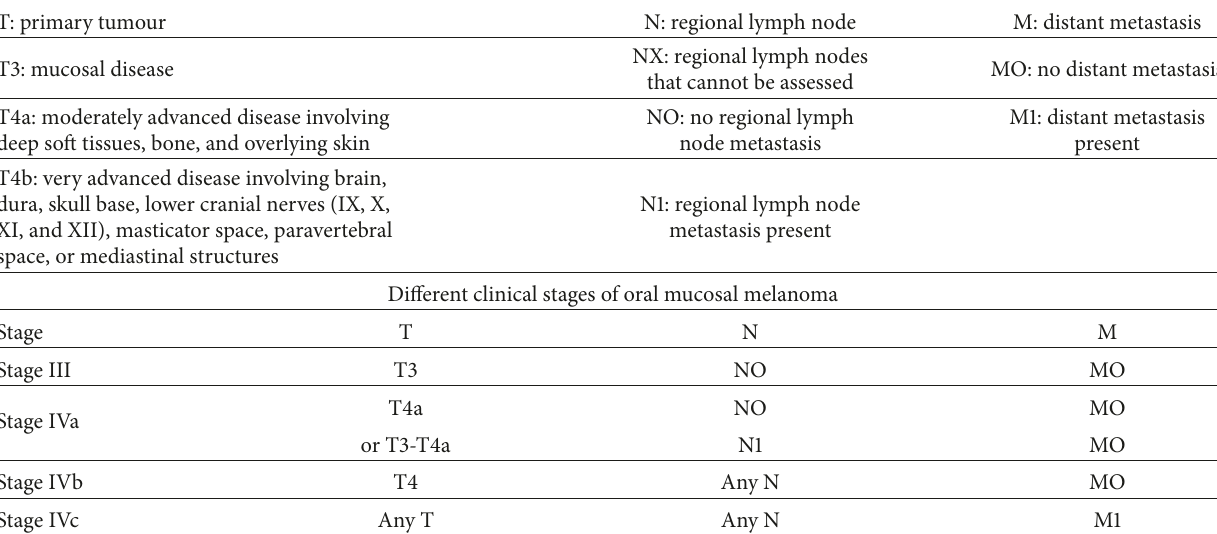
Table 2: American Joint Committee on Cancer (AJCC) TNM staging of mucosal melanoma [1–3,